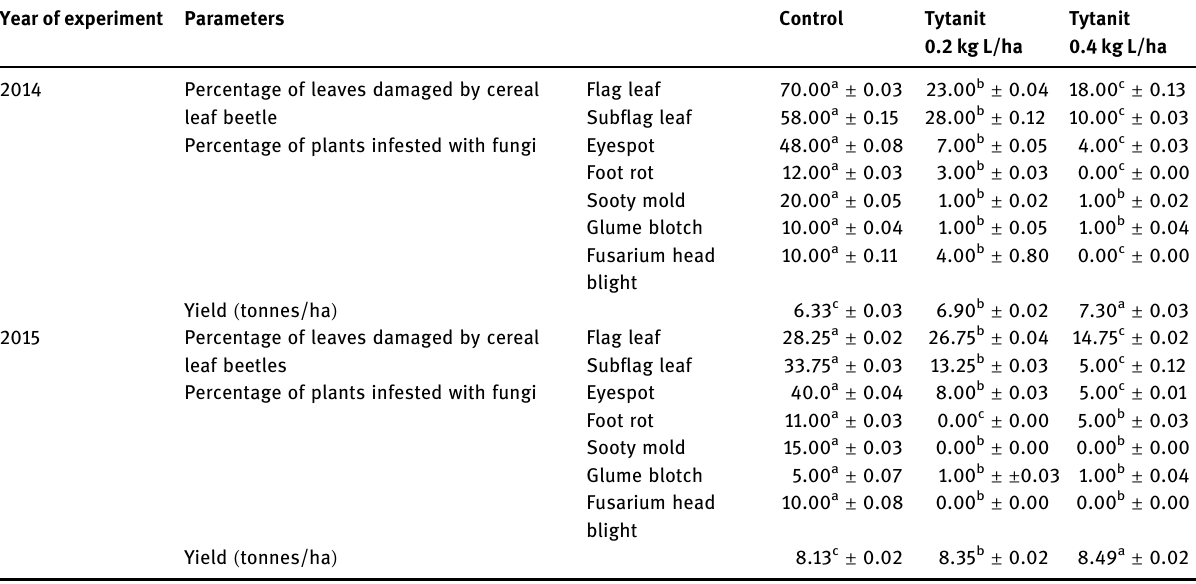
Table 3: The results of experiments on winter wheat. Mean values ± standard deviations Year of experiment